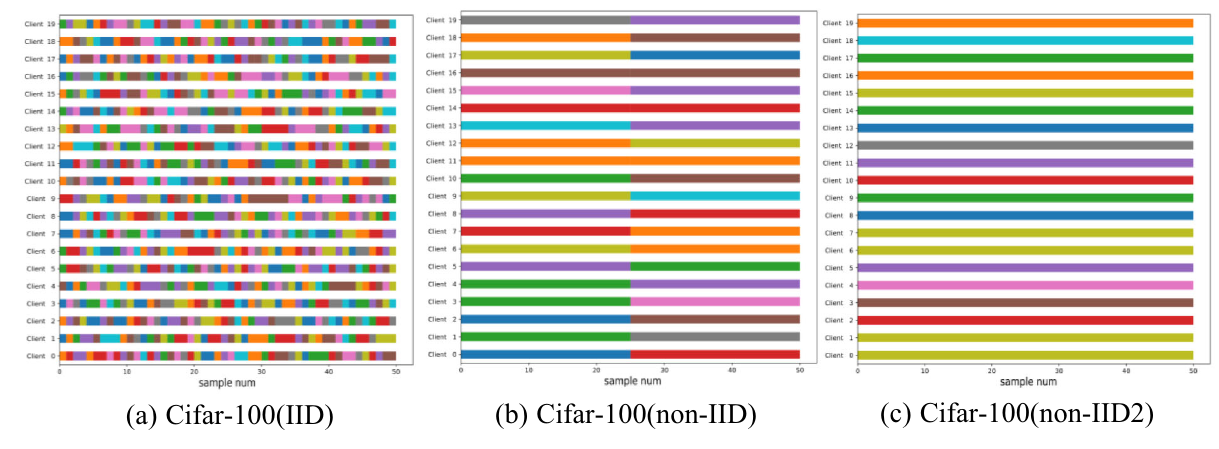
Fig. 2 Data distribution of the top 20 clients in the Cifar-100 dataset